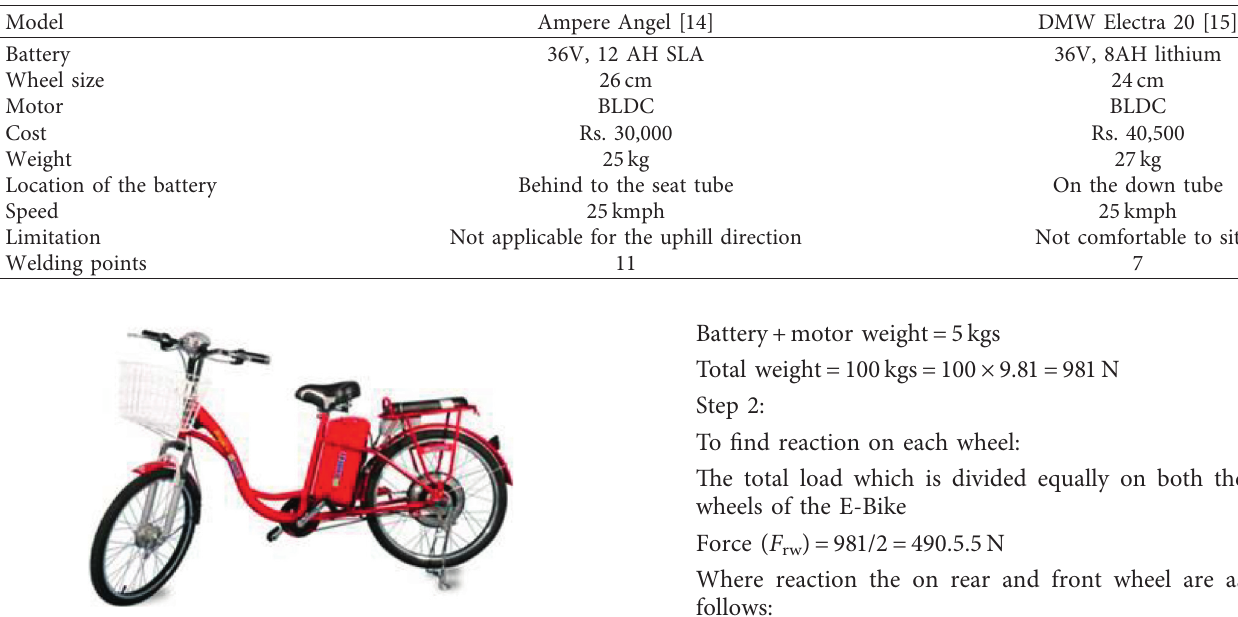
Figure 1: Prototype model of the Ampere Angel E-cycle [14].